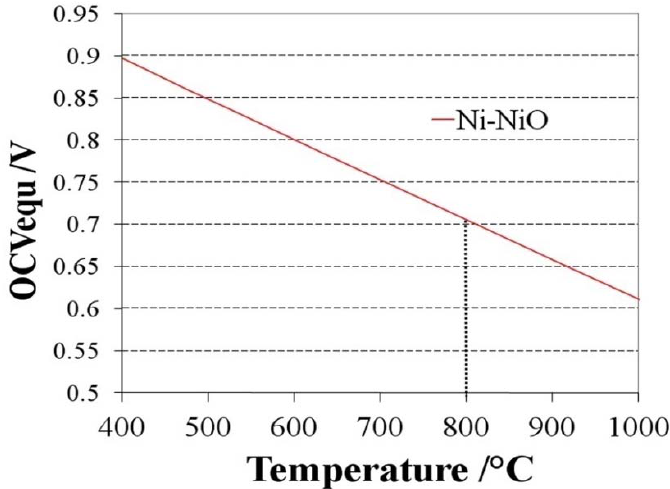
Figure 3. Open circuit voltage (OCV) or Nernst potential versus temperature for the Ni/NiO equilibrium